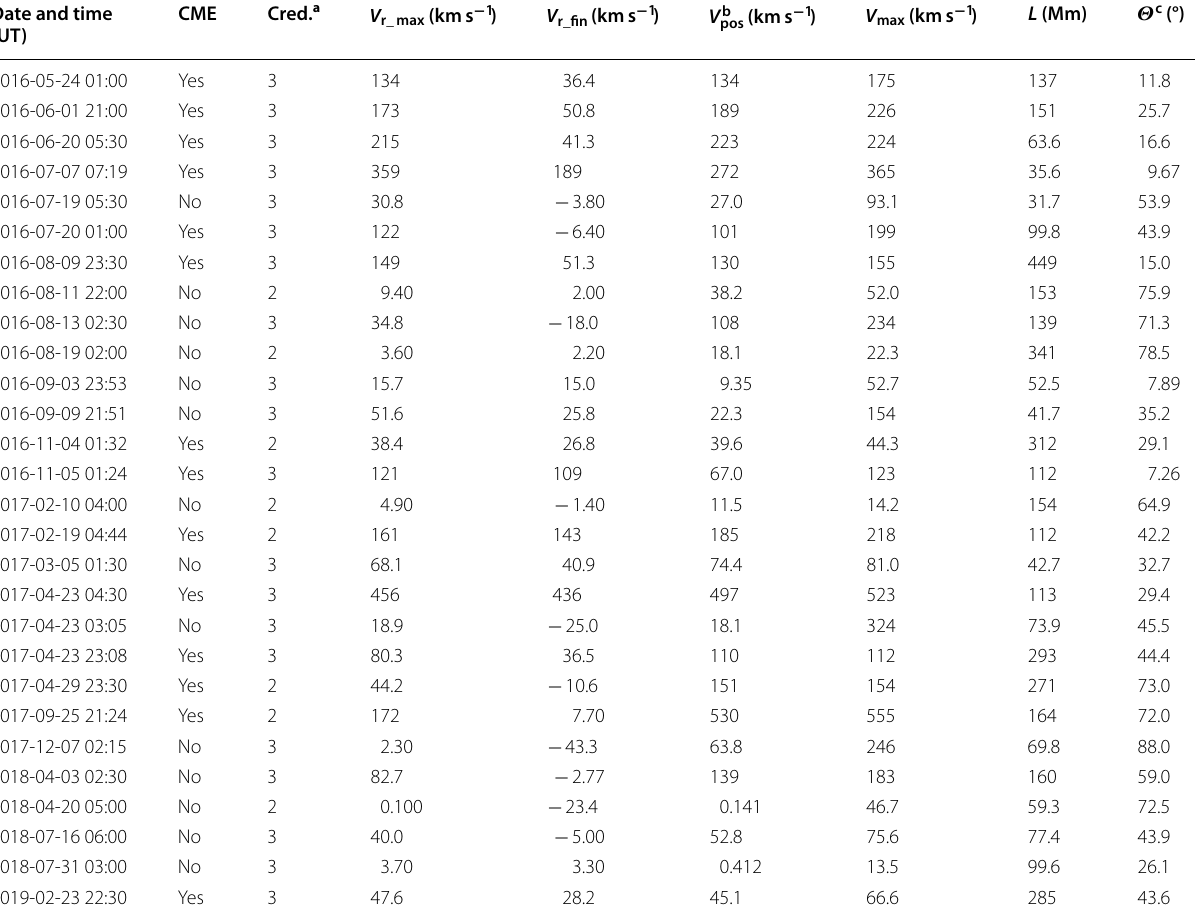
Table 2 Filament eruptions used in this study. Data are taken from the SMART/SDDI Filament Disappearance Catalogue (Seki et al.